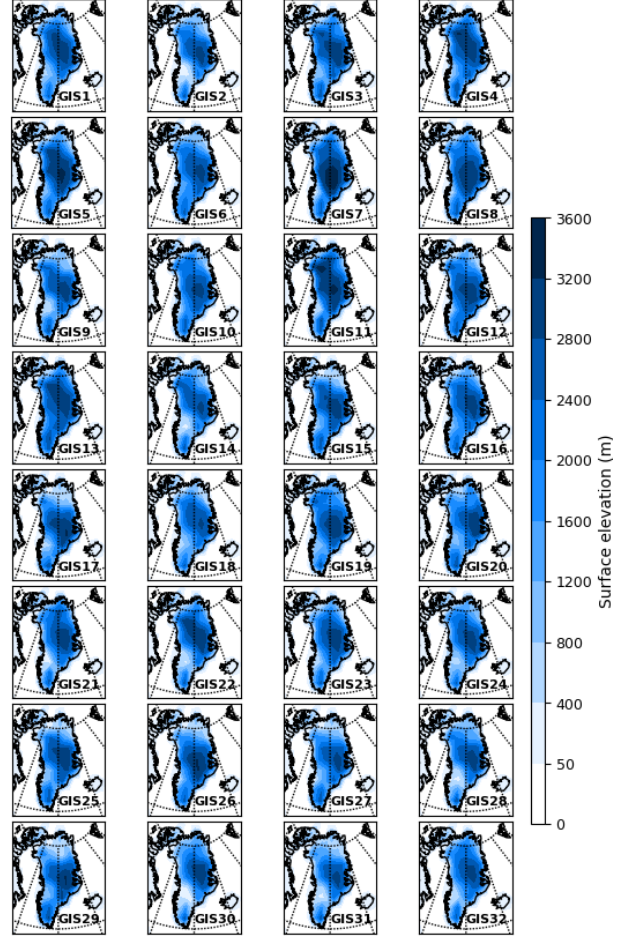
Figure A1. Surface elevation (metres) of LIG GIS morphologies used in the 32 simulations that examine the joint impact of modified Arctic sea ice retreat and modified GIS morphology. See Table A1 for more